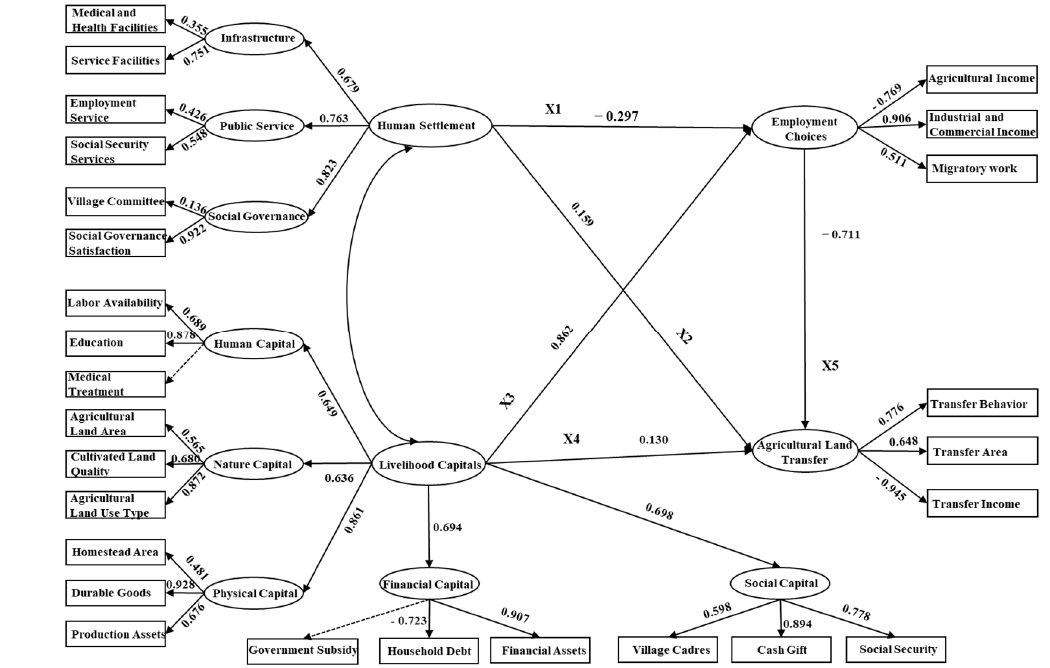
Figure 5. Parameter estimation results based on